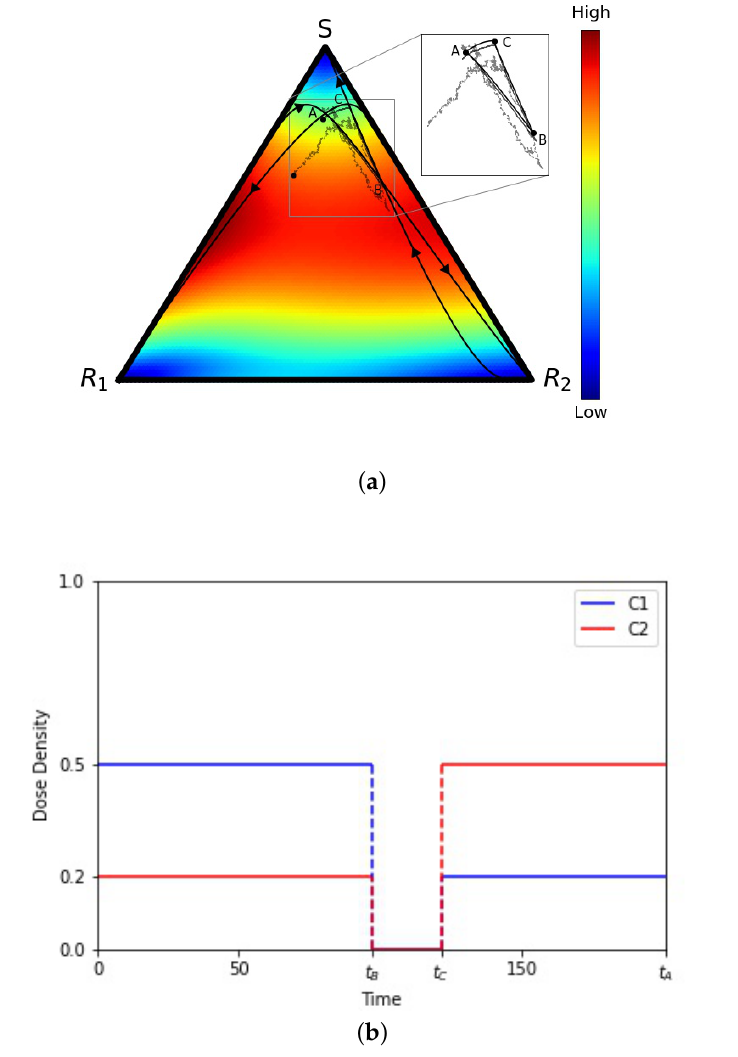
Figure 2. ( a ) Tri-linear ( S , R 1 , R 2 ) coordinate representation of a deterministic evolutionary cycle ABCA , from the adjusted replicator equation, and two stochastic realizations (from the Moran process) with N = 10,000 and N = 1,000,000 cells. Inset shows that the stochastic paths are not closed. Background colors show velocity field, hence instantaneous speed of convergence, from the adjusted replicator system. ( b ) Adaptive chemotherapy schedule with drugs 1 and 2 for closed cycle ABCA